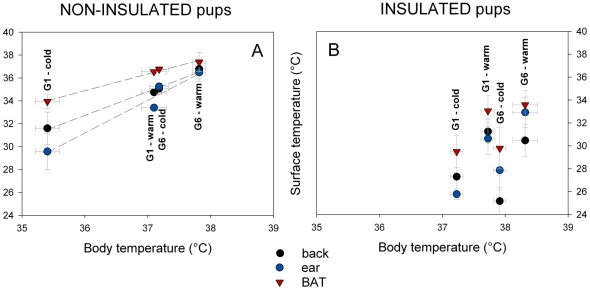
Surface temperature of back, ear and brown adipose tissue (BAT) of non-insulated (
Figure 5A
) and insulated (
Figure 5B
) pups (isolated, G1 or huddling, G6) as a function of their body temperature.Regression lines are statistically significant for non-insulated pups only. Non-insulated pups: TBAT = −17.79+1.46*Tb, r2 = 0.992, p = 0.004; Tear = −71.46+2.85*Tb, r2 = 0.950, p = 0.025; Tback = −42.14+2.08*Tb, r2 = 0.988, p = 0.006. Insulated pups: TBAT, r2 = 0.436, p = 0.340; Tear, r2 = 0.732, p = 0.144; Tback, r2 = 0.086, p = 0.707.